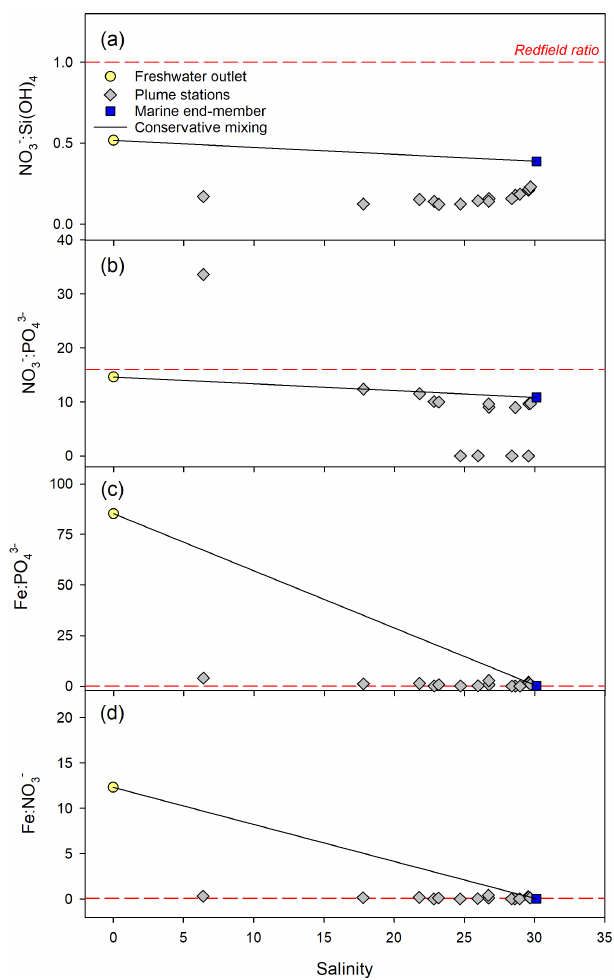
Figure 7. Stoichiometric ratios across the freshwater plume (0, 1, and 5m at six stations) at the outlet of watershed 819 during the rainfall event on 7 August 2015. Freshwater and marine end- members are the mean concentration at watershed 819 for the month of August and the plume sample with the highest salinity, respec-